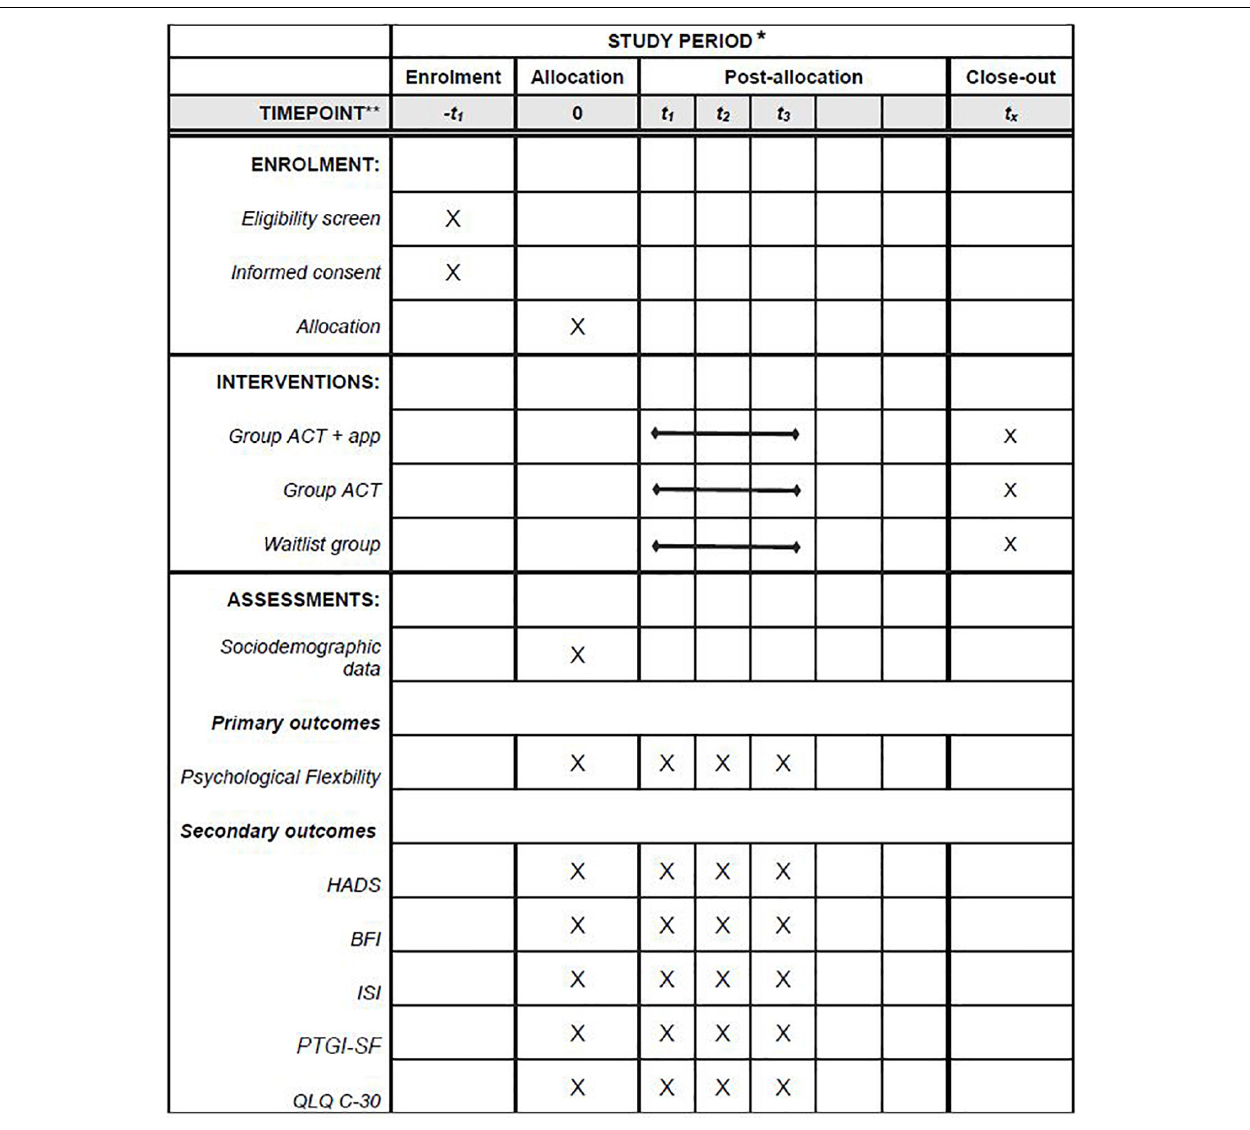
FIGURE 2 | Schedule of enrollment, interventions, and assessments. *Recommended content can be displayed using various schematic formats. See SPIRIT 2013. Explanation and Elaboration for examples from protocols. **List specific timepoints in this